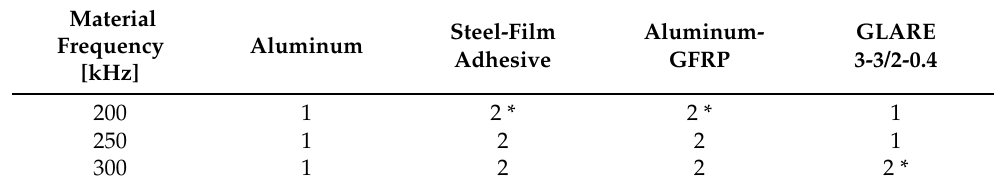
Table 5. Overview of the APDS-CWT assignment into signal group 1 and signal group 2. Positions that differ from the assignments in Table 4 are marked with an asterisk .